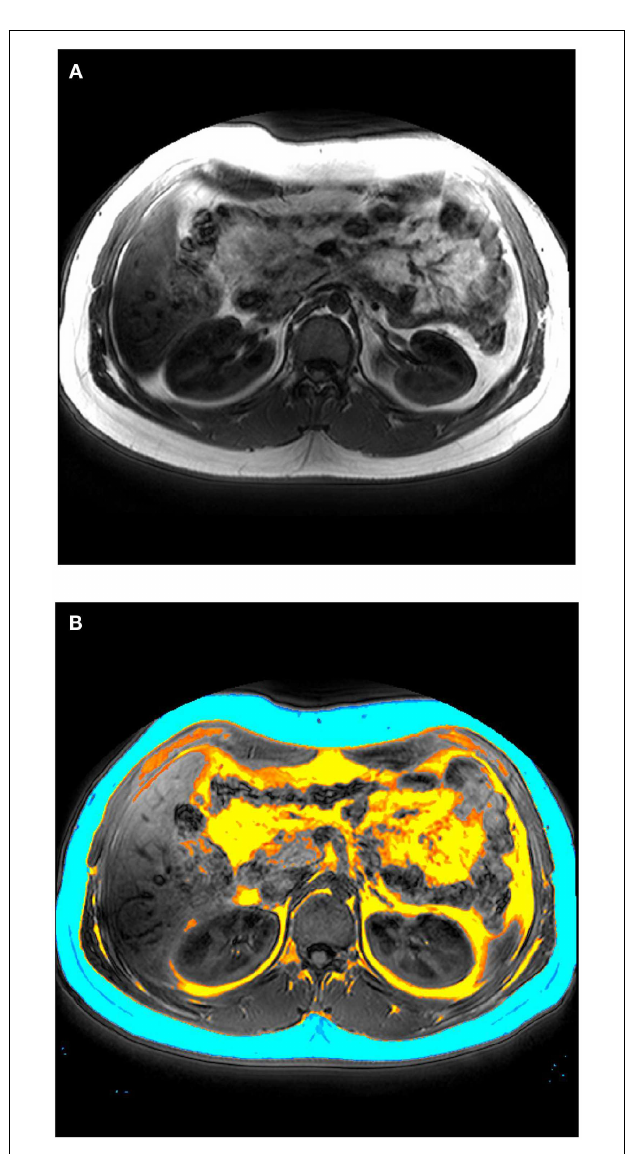
FIGURE 1 | (A) Representative MRI image (axial plane) performed on a 3-T clinical scanner. (B) Total visceral fat (yellow), subcutaneous fat (blue), and intramuscular fat (orange) manually